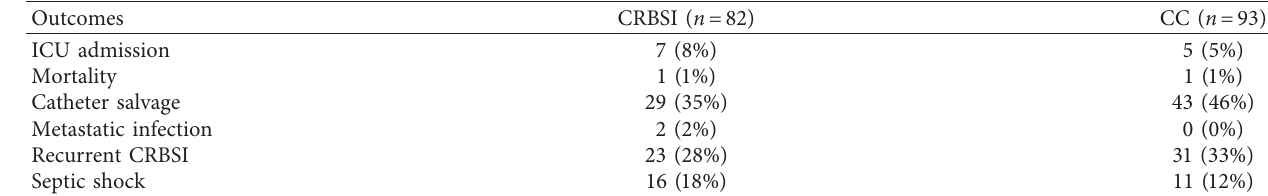
Table 3: Outcomes for CRBSI and CC groups.